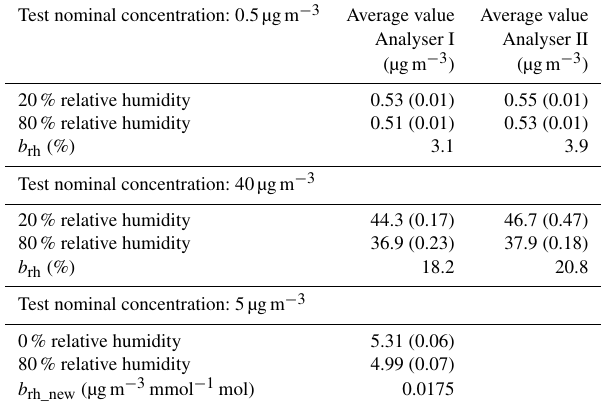
Table 2. Analyser readings when subjected to changes in ambient humidity for a constant reference concentration and sensitivity coef- ficients to humidity ( b rh and b rh_new ). Test temperature: 20 ± 2 ◦ C. In parentheses, the standard deviation of the